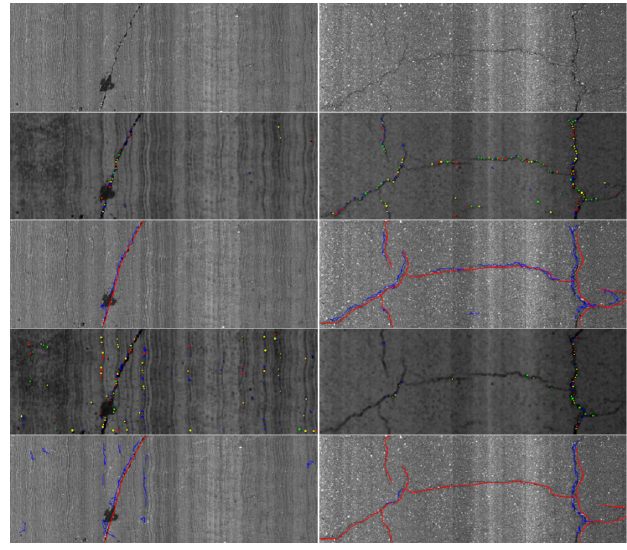
Figure 23. From upper to lower row: original image, seeds results with adaptive parameters, cracking results with adaptive parameters (ground truth in red; cracking in blue), seeds results with fixed parameters, cracking results with fixed parameters. Left column : example with false positives reported; Right column : example with false negatives